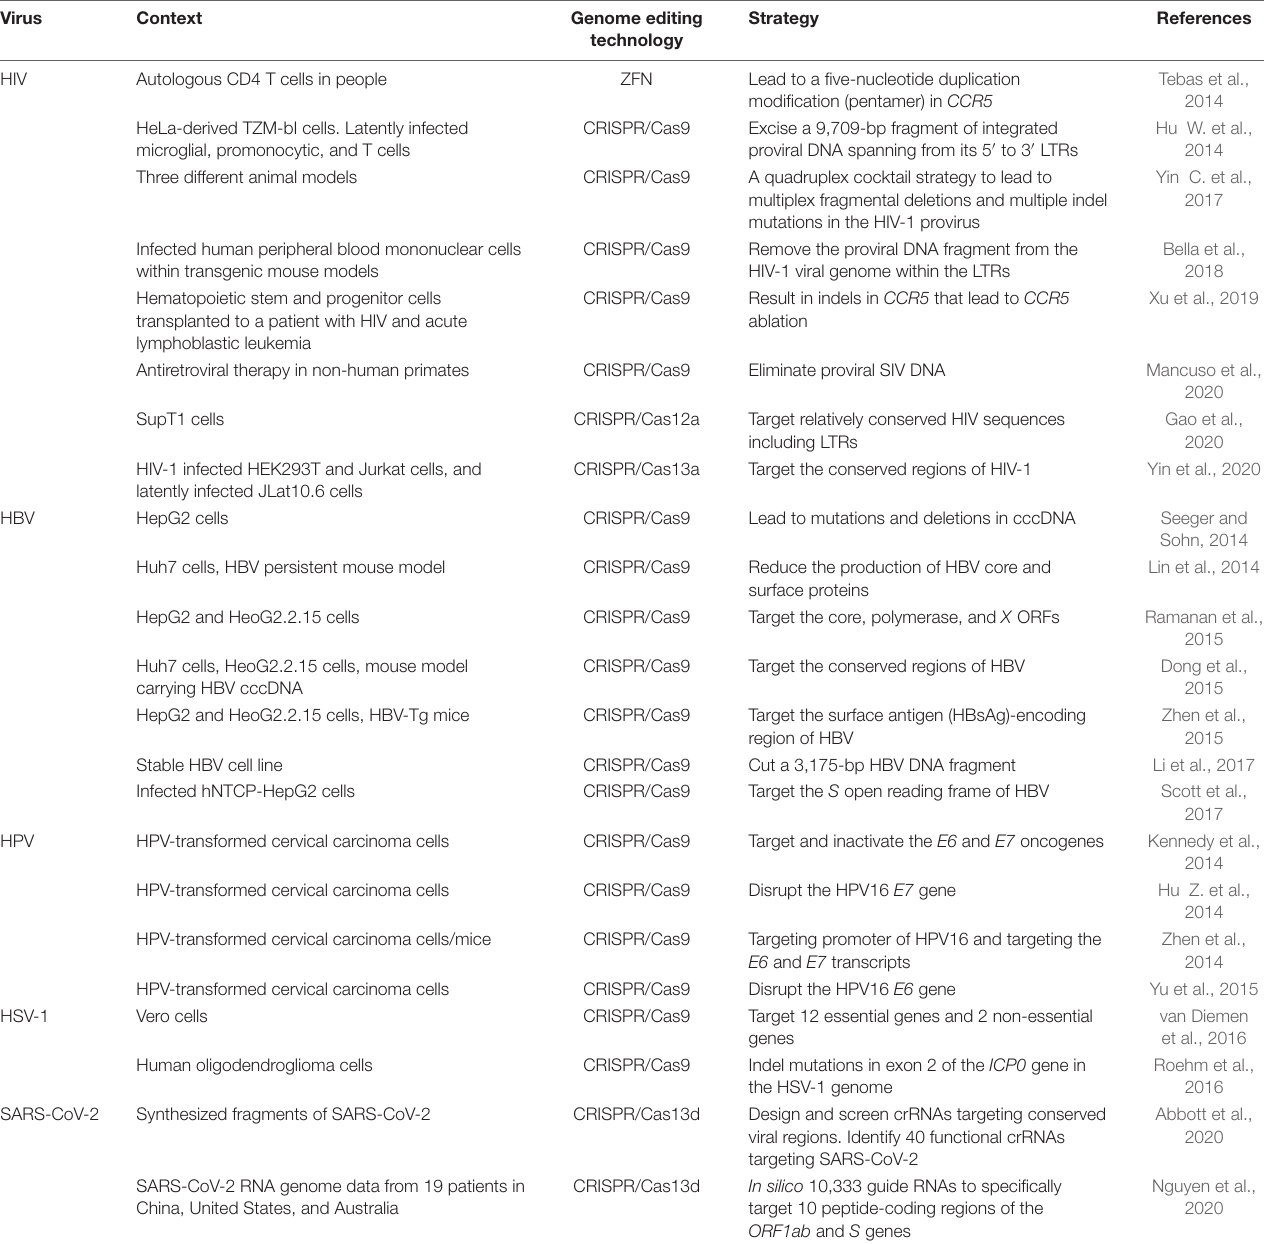
TABLE 1 | Recent studies of genome editing therapy for viral infectious